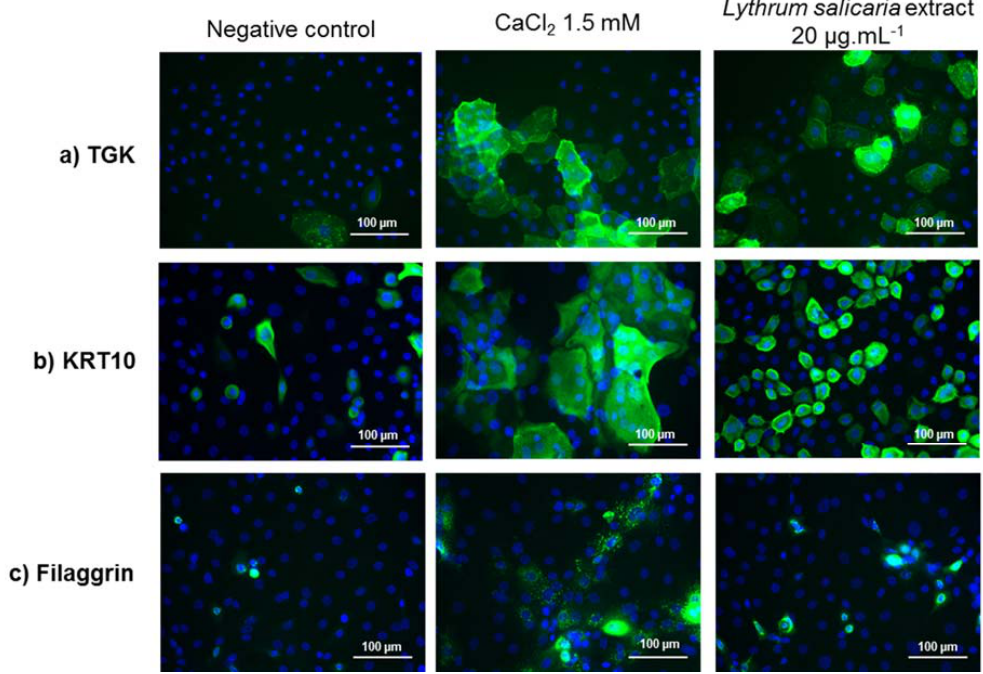
Figure 3. Immunofluorescence analysis of ( a ) TGK; ( b ) KRT10; and, ( c ) Filaggrin expressions in epidermal keratinocytes treated or not with CaCl 2 at 1.5 mM or Lyth. s . extract at 20 µ g · mL − 1 . After 72 h of treatment, the cells were fixed and proteins of interest were revealed using antibody directed against proteins of interest. Results are from one experiment representative of three. Cosmetics 2017 , 4 , 52